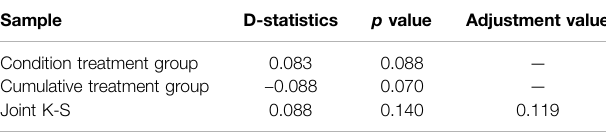
TABLE 3 | K-S normal distribution test. TABLE 4 | GPS value of the intervals of the treatment